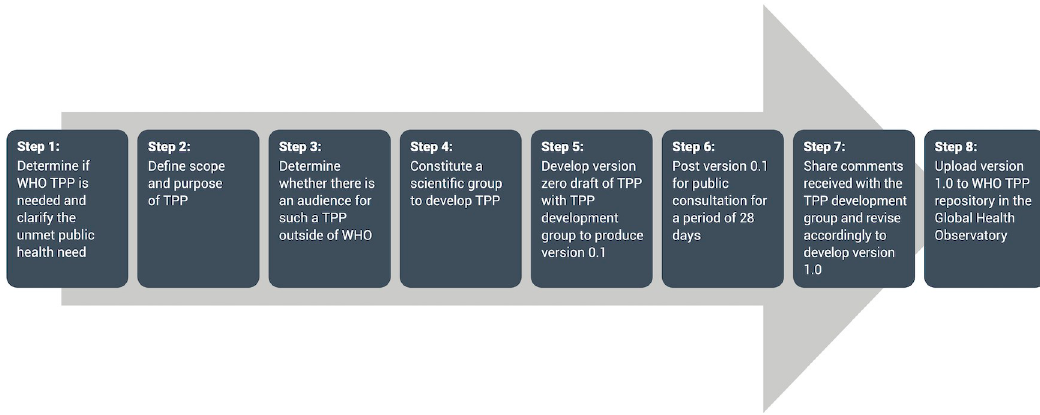
Fig 1. World Health Organization Target Product Profile